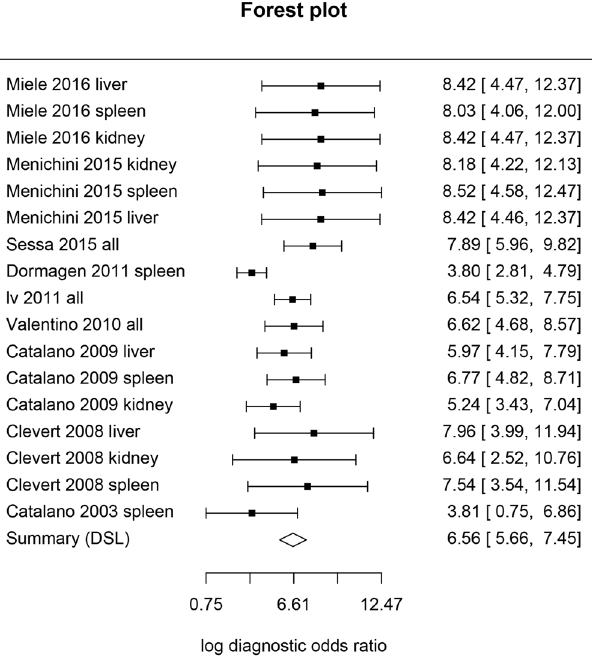
Figure 2. Forest plot showing log (diagnostic odds ratio [DOR]) for individual studies and summary estimate. The result showed that log(DOR) values ranged from 3.80 (95% CI: 2.81–4.79) to 8.52 (95% CI: 4.58–12.47). The combined log(DOR) was 6.56 (95% CI: 5.66–7.45). The Cochran’s Q was 11.265 (p = 0.793 with 16 degrees of freedom), and the Higgins’ I 2 was 0%.